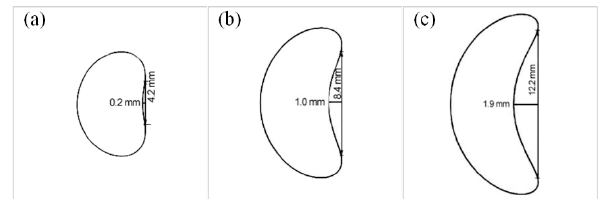
Figure 15. Cross-section shapes of spiral part with different d s ( h s = 14 mm and d w = 5 mm): ( a ) d s = 8 mm, θ = 29.1° and bending degree (BD) = 0.12; ( b ) d s = 10 mm, θ = 24.0° and BD = 0.24; and ( c ) d s = 14 mm, θ = 17.6° and BD = 0.31.